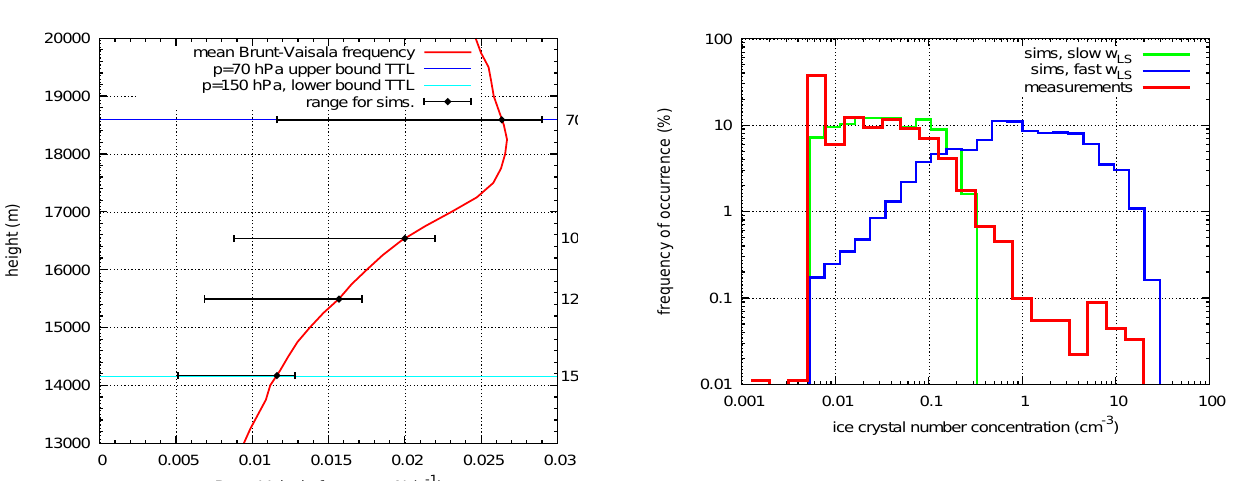
Fig. 8. Frequencies of occurrence of ice crystal number concen- trations from simulations with pure homogeneous freezing in very slow and faster large-scale motions ( w LS ≤ 1cms − 1 , green; w LS > 1cms − 1 , blue); the red line represents the measurements of Krämer et al. (2009). Note that the detection limit of the measurements is N i ∼ 0 . 005cm − 3 ; thus, the lowest concentration bins of the model simulations are clipped for better comparison with the measure-